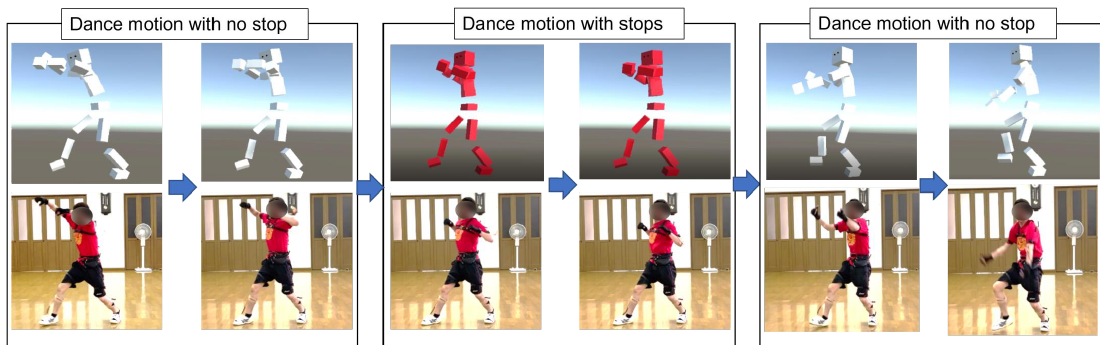
Figure 7. Motion data